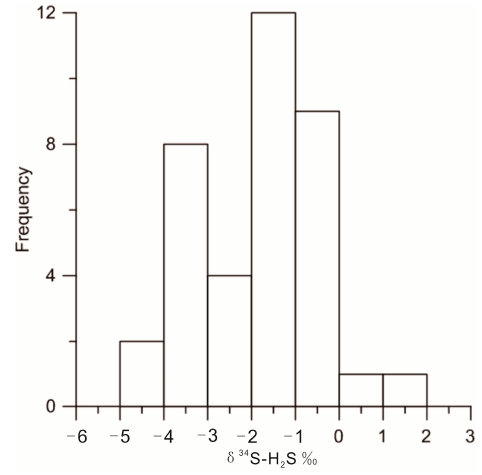
Figure 4. Histogram showing the sulfur isotopic composition of the Shimensi sulfides.